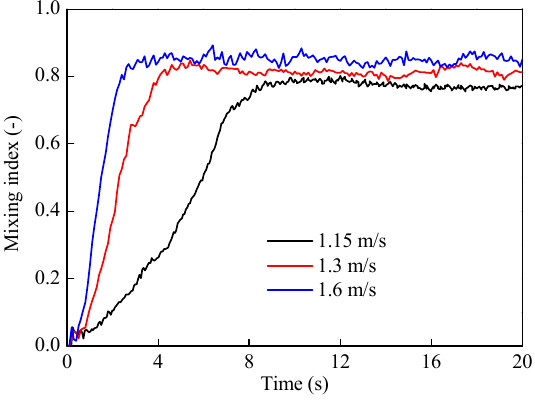
Figure 7. Time evolutionary profiles of mixing index with different superficial gas velocities.